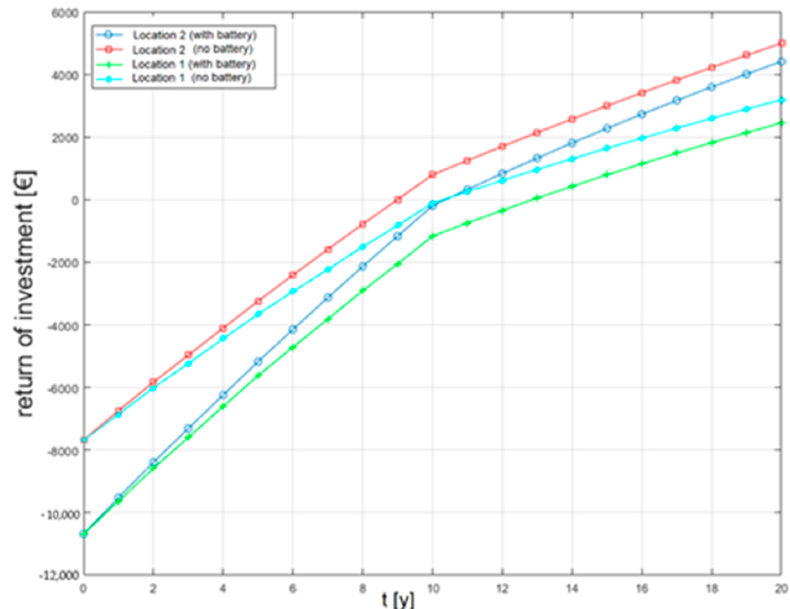
Figure 18. The return of investment.